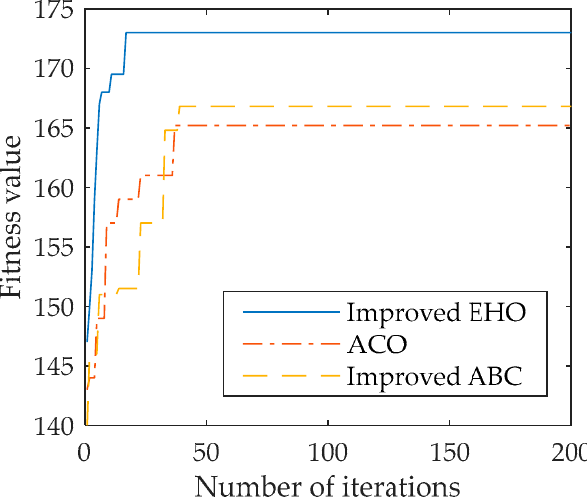
Figure 9. Comparison of fitness values of three methods.